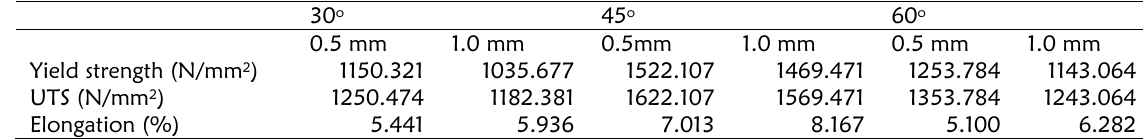
Table 3: Tensile test result for AISI 1065 steel (HCS)